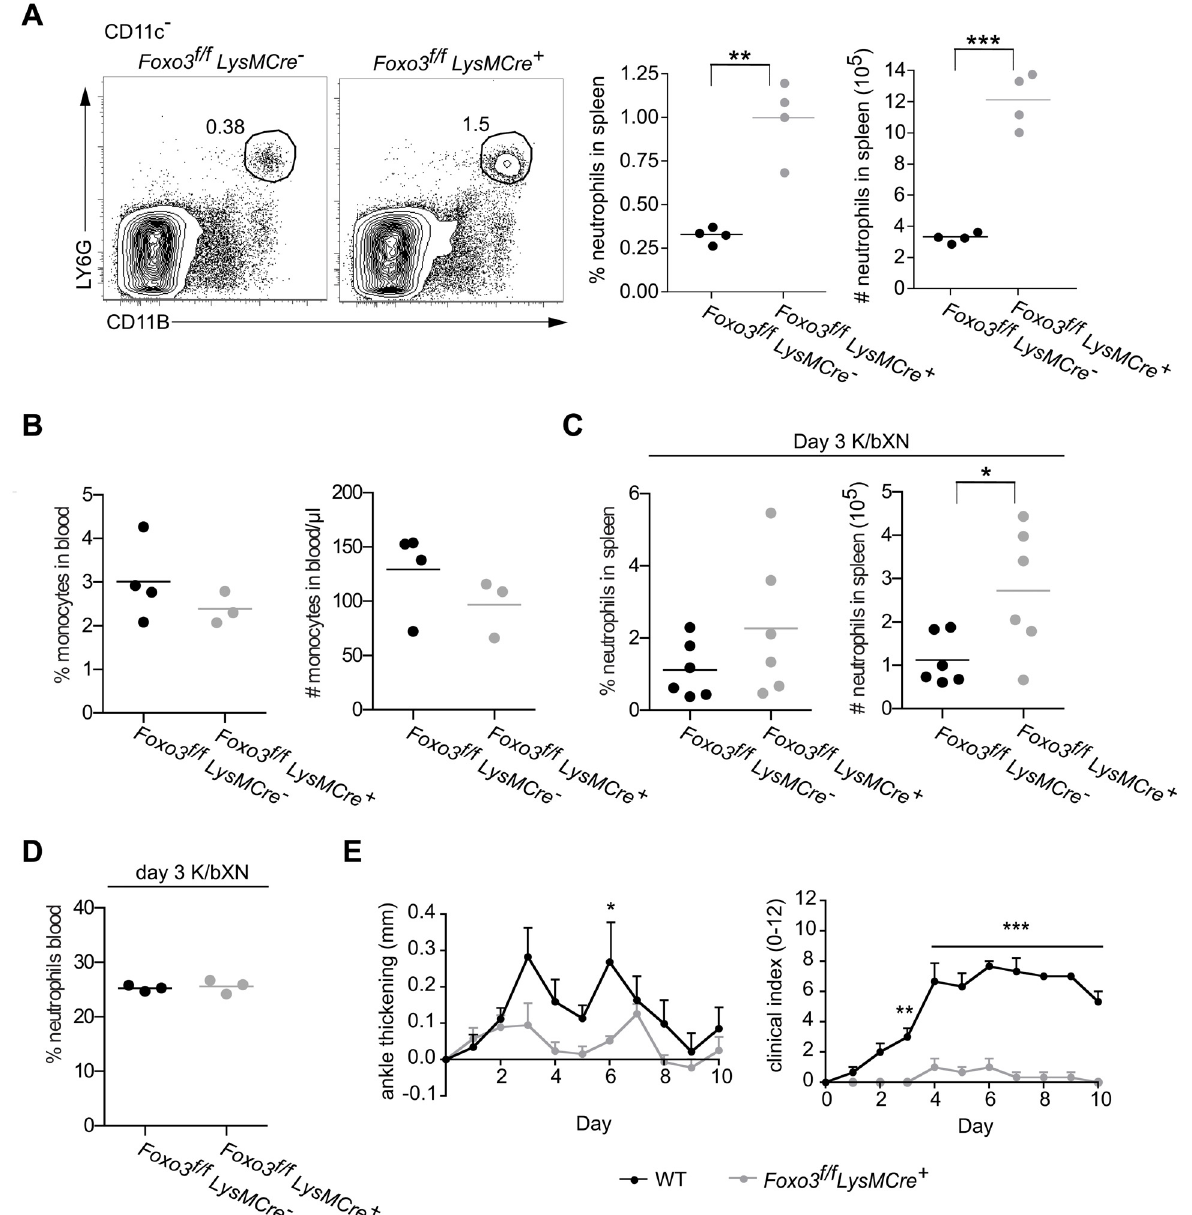
Fig 5. Neutrophilia and protection from K/BxN-serum transfer arthritis in the absence of FOXO3 are myeloid cell-intrinsic. (A) The frequency of LY6G hi CD11B hi cells in spleens Foxo3 f/f LysMCre - or Foxo3 f/f LysMCre + mice was determined by flow cytometry and the absolute number of neutrophils in each spleen was calculated. Data are representative of three experiments with at least four mice per group. (B) CD115 + monocytes in the blood were determined by flow cytometry. Data shown are representative of 2 independent experiments. (C-D) Foxo3 f/f LysMCre - or Foxo3 f/f LysMCre + mice were injected with K/BxN sera on d 0 and on d 3 neutrophils in the (C) spleen and (D) blood were determined by flow cytometry. (E) Foxo3 f/f LysMCre - and Foxo3 f/ f LysMCre + mice were injected i.p. with K/BxN sera on d 0 and d2. Ankle thickness (Left) was measured and the mice were clinically scored (Right) in a blinded fashion. Data are representative of three experiments. Clinical index was calculated by combining the score for all four paws on each